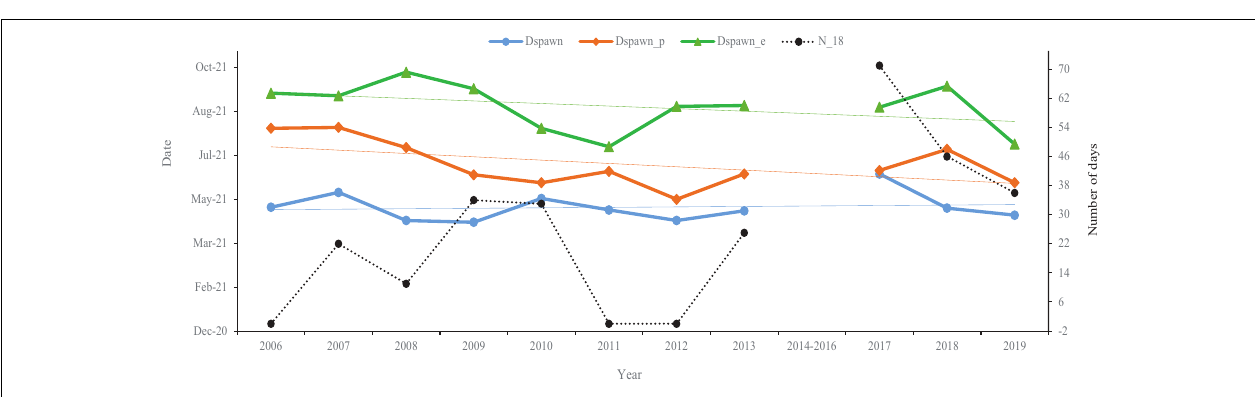
FIGURE 3 | Variations in the timing of silver carps’ spawning characteristics and the number of days with a temperature greater than or equal to 18 ◦ C from January to March (N_18). The data are collected in the Pearl River (China) during 2006–2013 and 2017–2019. The earliest date of spawning (blue; Dspawn), the peak spawning date (orange; Dspawn_p), the end of spawning (green; Dspawn_e). Faint lines of similar colors denote the trend